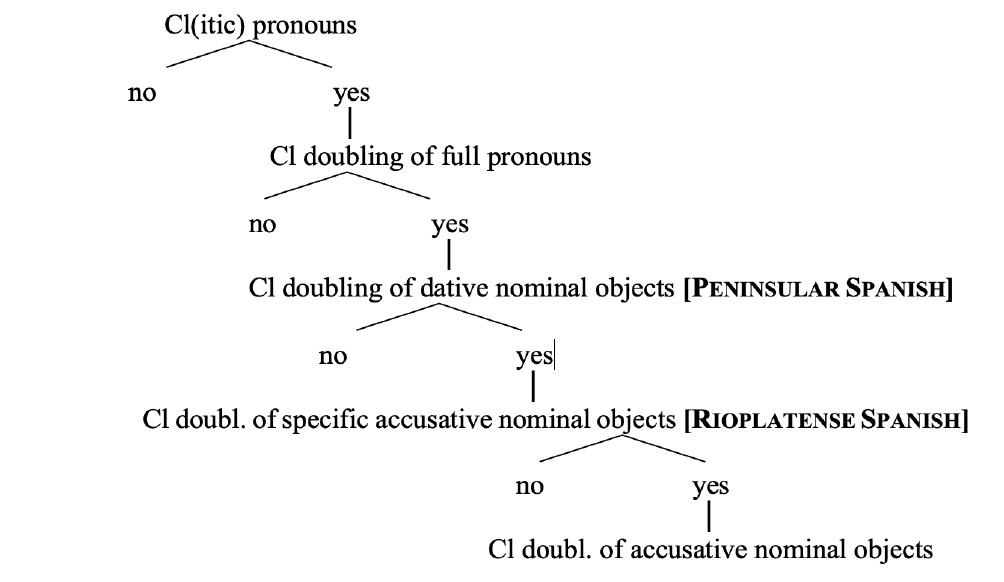
Figure 2. Parameter hierarchy from Fischer and Rinke (2013) (building on Baker 2008: 3, see also Roberts 2011). Note that the figure abstracts over grammatical features like animacy, person and definiteness, which may additionally influence the diachronic